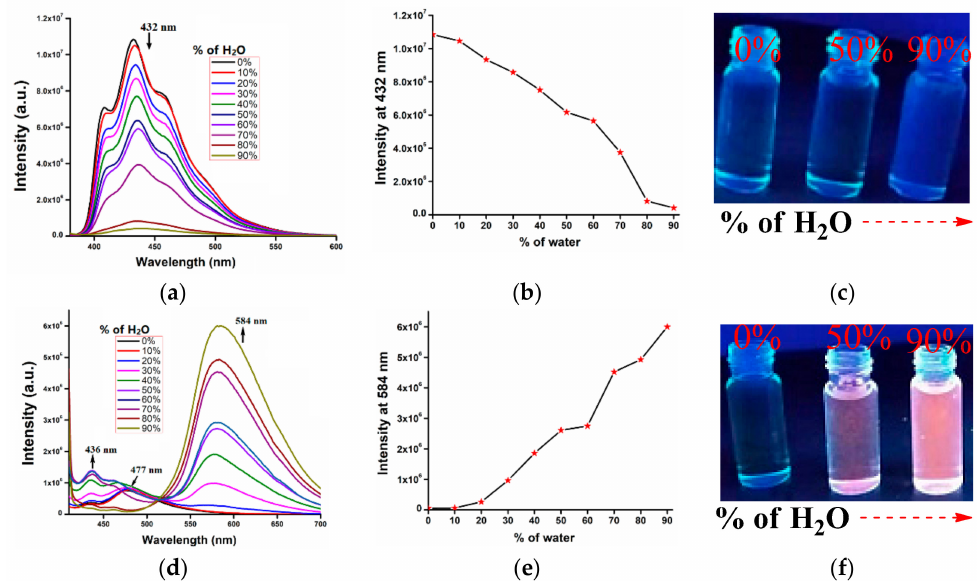
Figure 4. Fluorescence spectra of ( a ) AIE-1 (20 µ M) excited at 365 nm and ( d ) AIE-2 (20 µ M) excited at 400 nm in THF with ( b ) and ( e ) di ff erent water fractions. ( c) and( f ) Intensity vs. water fraction plots of AIE-1 and AIE-2. Fluorescence images of AIE-1 (20 µ M) and AIE-2 (20 µ M) under 365 nm UV lamp in THF with 0%, 50%, and 90%